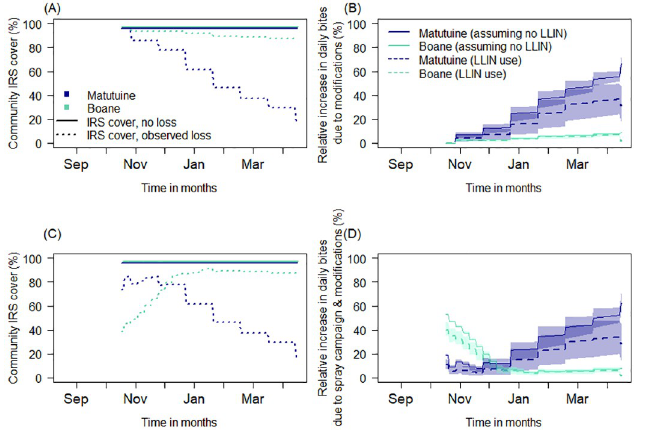
Fig 5. Comparison of factors impacting the IRS effectiveness. Assuming overnight delivery of IRS in October; ( A ). Change in post-IRS spray cover due to room modification or addition (accumulated data in Table 1) in Matutuine (blue) and Boane (green) districts sprayed with an organophosphate active and a neonicotinoid active, respectively; ( B ). The relative increase in daily mosquito biting rates in each district assuming overnight spraying in October in the presence (dashed lines) and absence (solid lines) of mosquito net use. That is, the estimated percentage increase in mosquito bites received per person relative to what we would expect without any household modifications reducing IRS effective cover. In contrast, ( C ). change in post-IRS spray coverage given the spray campaigns are completed over multiple months and household wall modification is ongoing in Matutuine (dotted blue) and Boane (dotted green) districts, compared to assuming IRS cover is as reported at completion and without modifications (solid lines: 96% for Matutuine, blue; or 97.1% for Boane, green); ( D ). Change in mosquito biting rates relative to assuming no loss